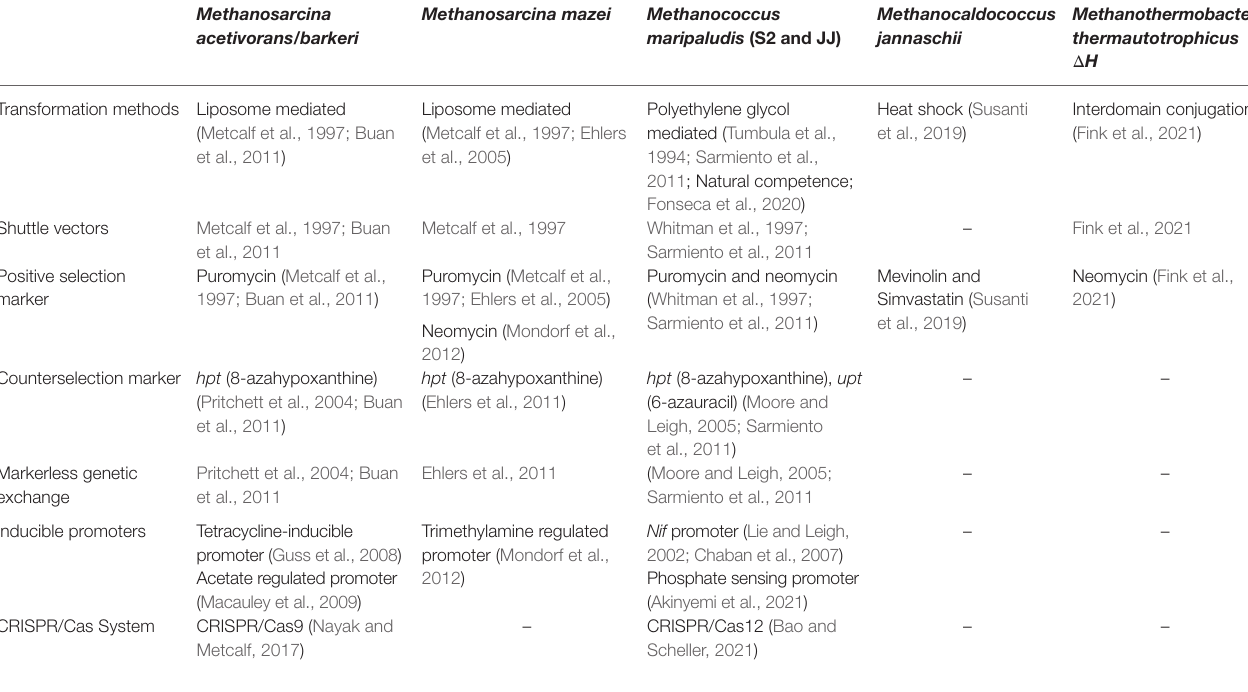
TABLE 2 | Summary of major genetic tools available in methanogens with associated